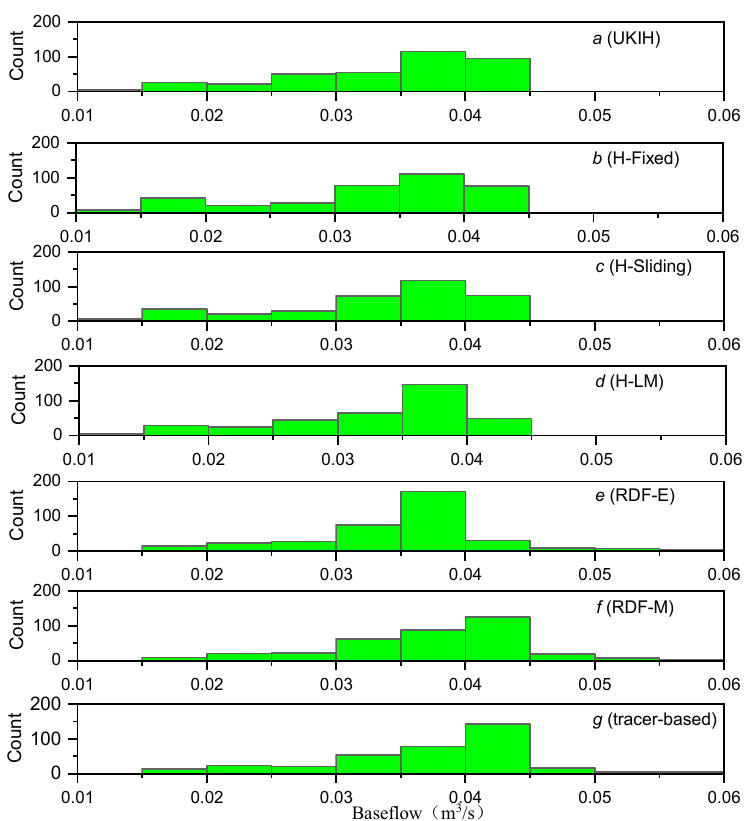
Figure 10. Histogram of baseflow obtained by different baseflow separation methods ( a ) UKIH, ( b ) H-Fixed, ( c ) H-Sliding, ( d ) H-LM, ( e ) RDF-E, ( f ) RDF-M, ( g ) tracer-based method. Water 2020 , 1 , x FOR PEER REVIEW